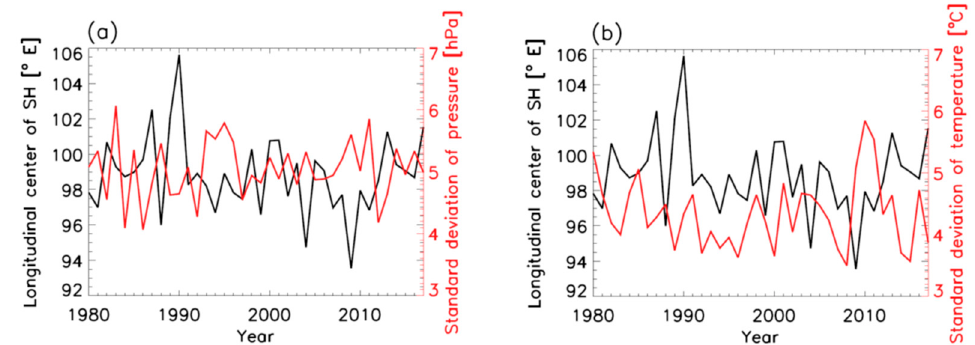
Figure 9. Time series of the standard deviation of daily averaged ( a ) surface pressure (left panel) and ( b ) temperature (right panel) against the longitudinal center of Siberian High for 1979–2017. The red lines indicate the standard deviation, and the black line shows the longitudinal center of the Siberian High. The units are hPa and °C, respectively.